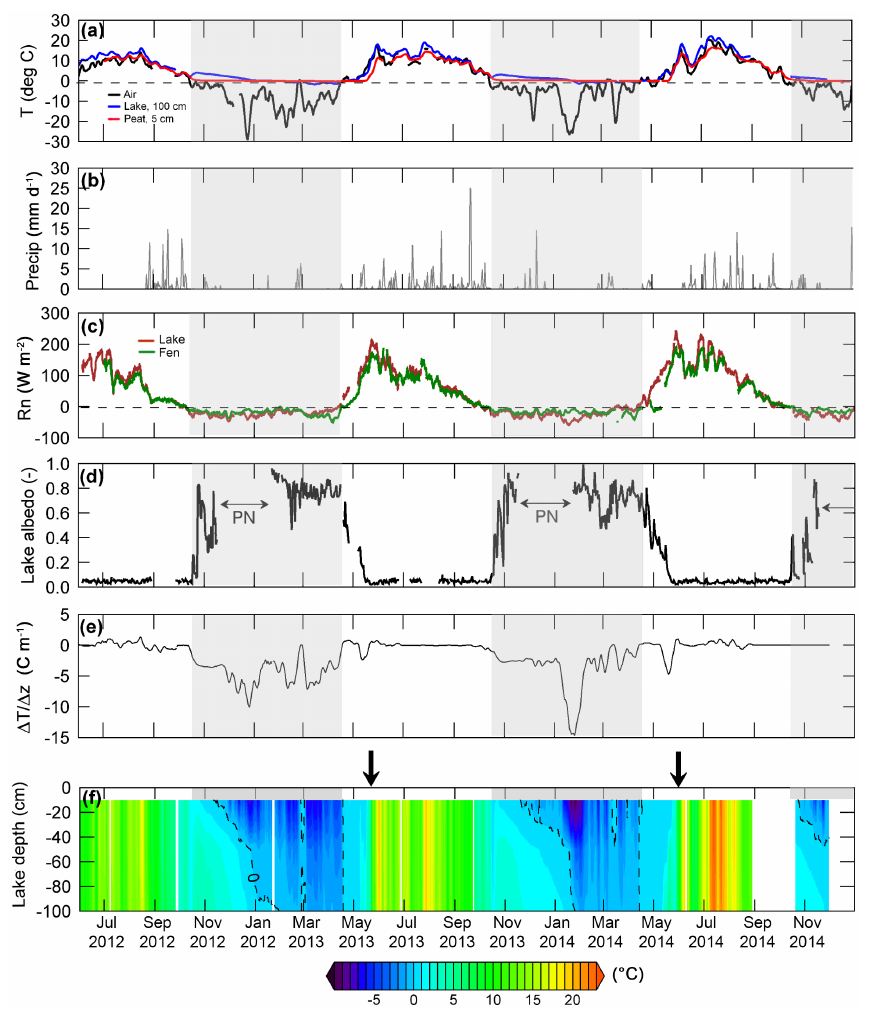
Figure 2. Daily mean of air, peat, and surface sediment temperature (a) ; cumulative daily precipitation (b) ; daily mean net radiation input at the fen and the lake surfaces (c) ; albedo of the lake surface (d) ; daily temperature gradient in the lake water column defined as ( T w , 10 cm − T w , 100 cm ) divided by the depth difference (cid:49)z (e) ; water temperature profile in the lake center derived from continuous daily temperature measurements at depths 10cm, 30cm, 50cm, and 100cm ( = bottom) (f) . The shaded areas indicate the periods of ice cover at the lake. PN stands for polar night, i.e., near zero solar input. The black arrows indicate the estimated time of complete lake overturn after